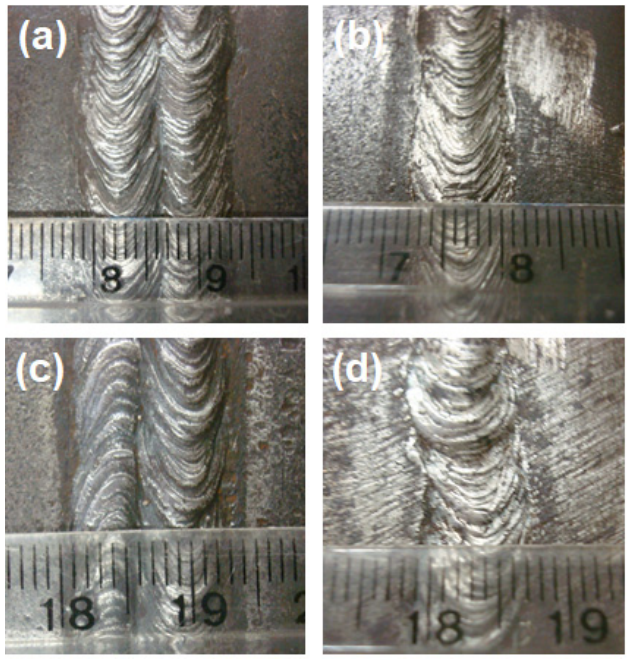
Figure 1. Typical Q&T HHA steel welded joints. With higher heat input: ( a ) top and ( b ) root. With lower heat input: ( c ) top and ( d ) root. (Ruler small divisions in mm).